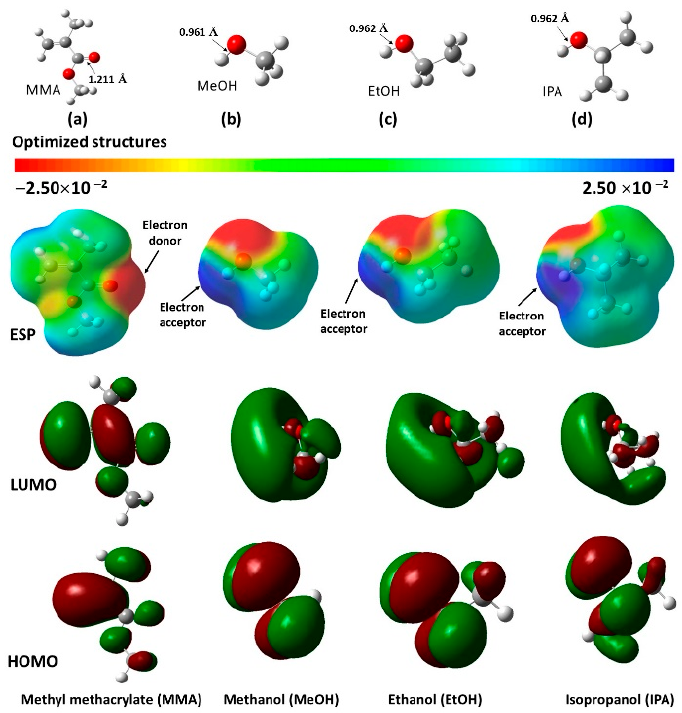
Figure 8. Optimized gas phase molecular structures, ESPs, LUMOs, and HOMOs structures of ( a ) MMA, ( b ) methanol (MeOH); ( c ) ethanol (EtOH), and ( d ) isopropanol (IPA) at the B3LYP/6- 311++G(d,p) level of theory.